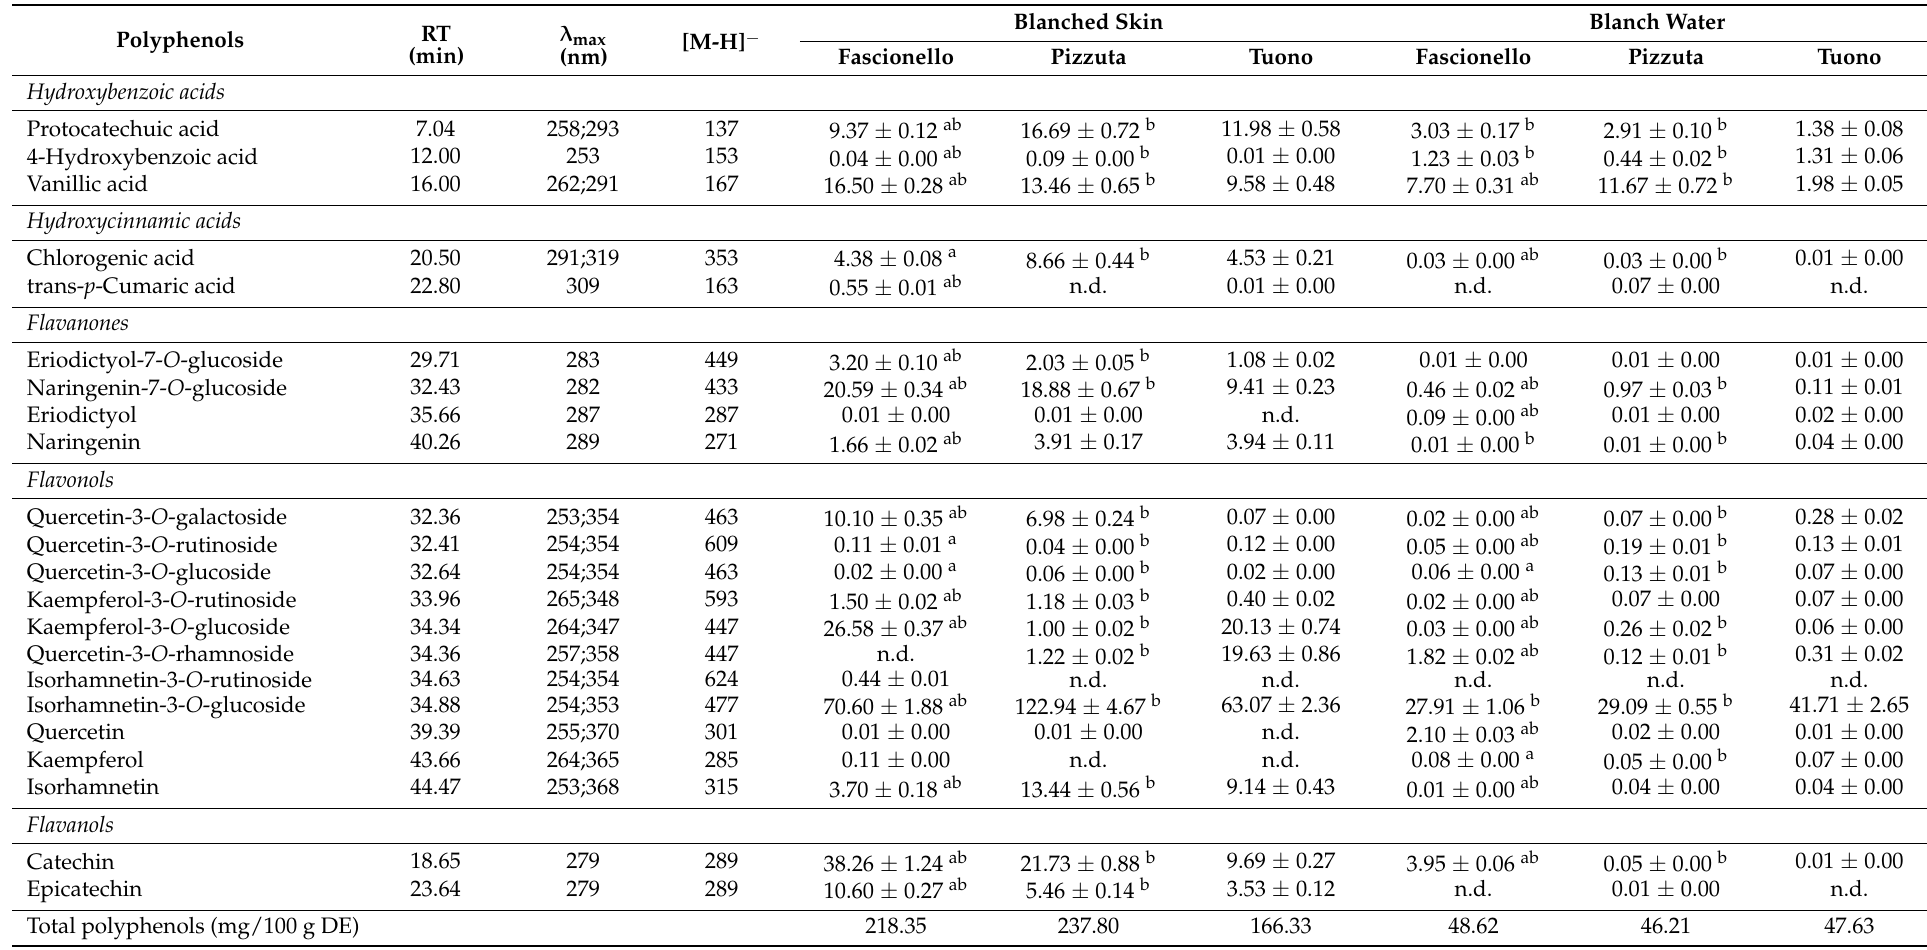
Table 4. Qualitative and quantitative determination of polyphenols in blanched skin and blanch water samples belonging to three almonds’ cultivars (Fascionello, Pizzuta, and Tuono) by LC-DAD-ESI-MS analysis. For the Fascionello and Pizzuta cultivars, the average data of the six producers were reported. Results, which represent the average ± standard deviation of three independent experiments in triplicate ( n = 3), were expressed as mg of each polyphenol/100 g of dried extract